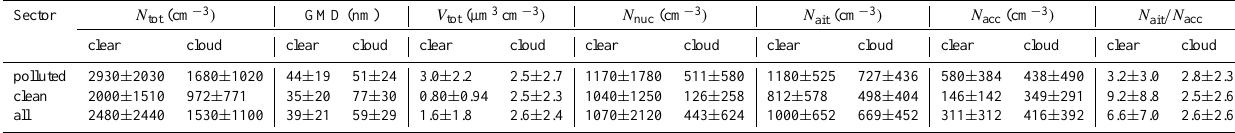
Table 2. Average values and standard deviations of total particle number concentration ( N tot ) , geometric mean particle diameter (GMD), total particle volume concentration ( V tot ) , number concentrations of nucleation, Aitken and accumulation mode particles ( N nuc , N ait , N acc ) and ratio N ait /N acc . Values are calculated from the twin-DMPS data for the sectors with and without local pollutant sources, for the whole data set and for both clear and cloudy conditions. Data are from the total sampling line.